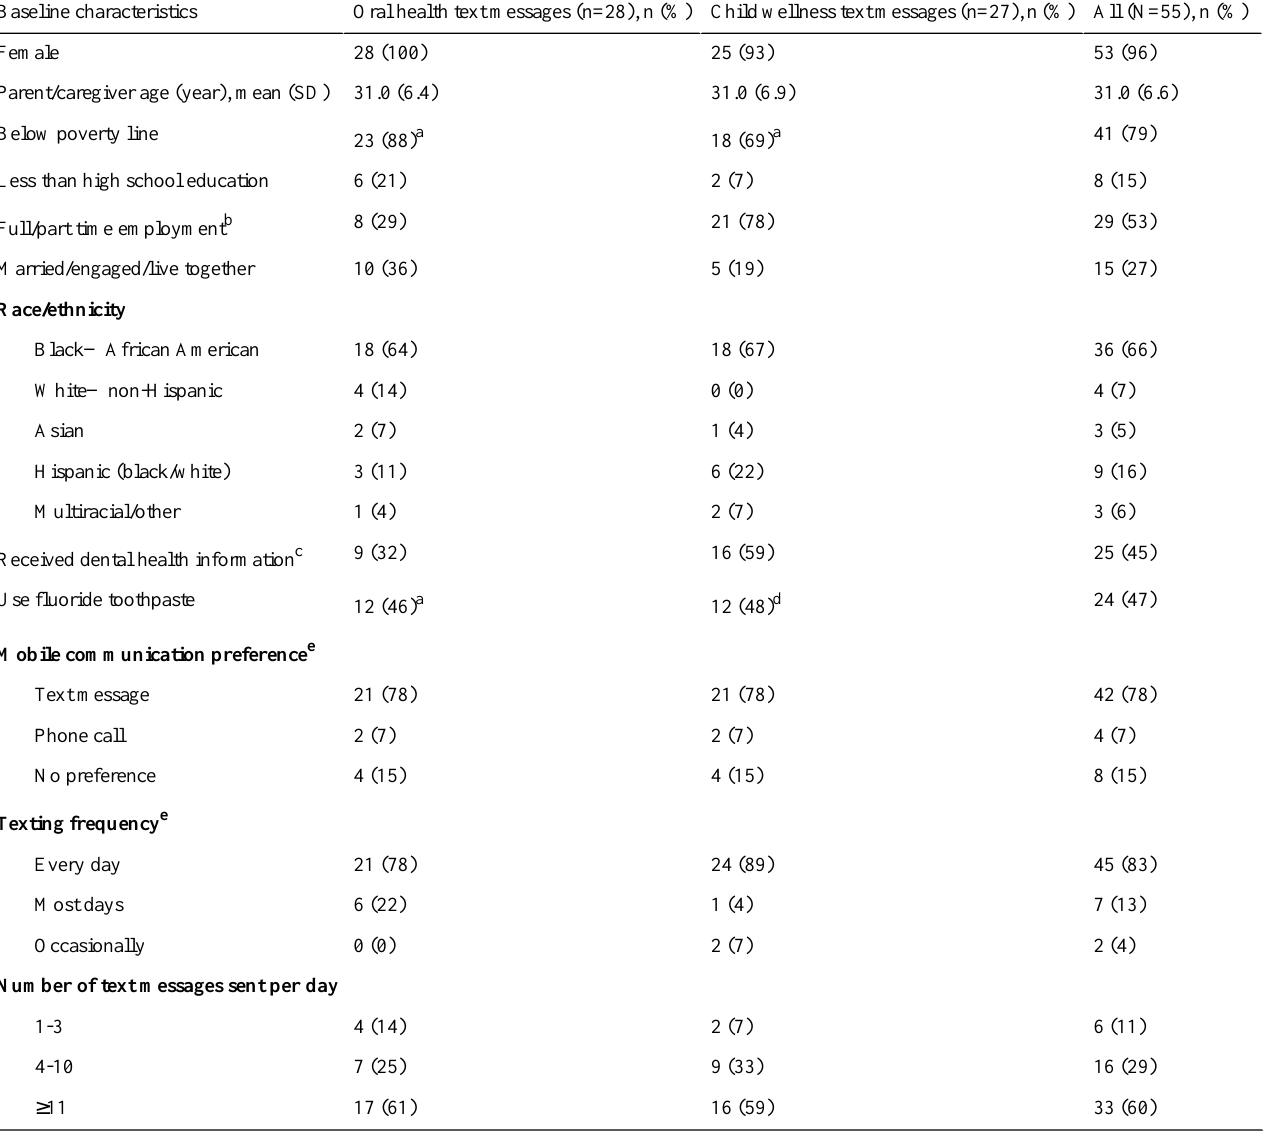
Table 1. Baseline characteristics of participants by treatment